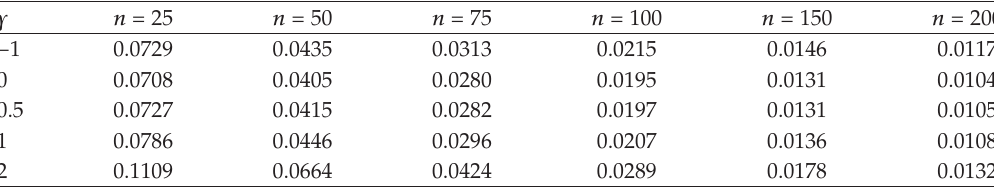
Table 3: MSE of the estimates for the exponential distribution, B (cid:6)